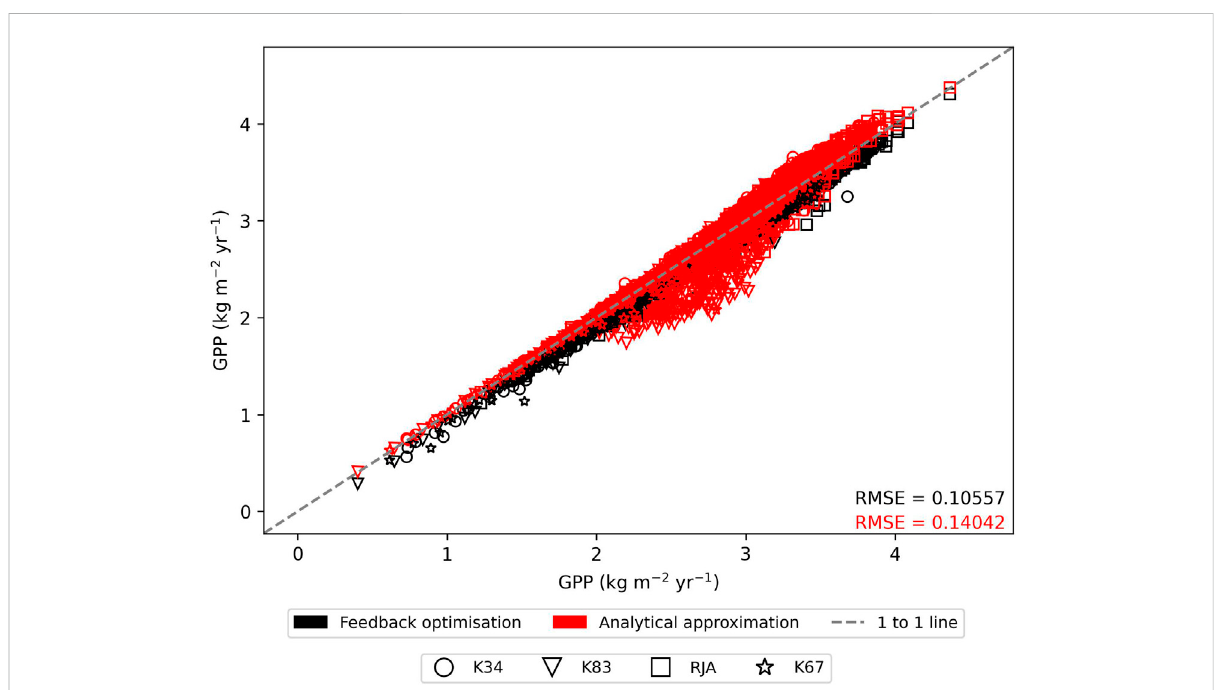
The comparison of predicted daily grid-box gross primary production (GPP, kg C m − 2 yr − 1 ) from the numerically solved version of JULES-SOX along the x axis against 1) feedback control version of JULES-SOX (black) and 2) the semi-analytical approximation of JULES-SOX (red) along the y-axis, across simulations from four sites in the Amazon rainforest. The sites are LBA-K34: Reserva Cuieiras, Manaus Brazil; LBA-K83: Tapajos National forest, Santarem Brazil; LBA-RJA: Reserva Jaru; LBA-K67: Tapajos National forest, Santarem Brazil. Root mean square error (RMSE) values between values predicted by the numerical version and the two other versions across all simulations are